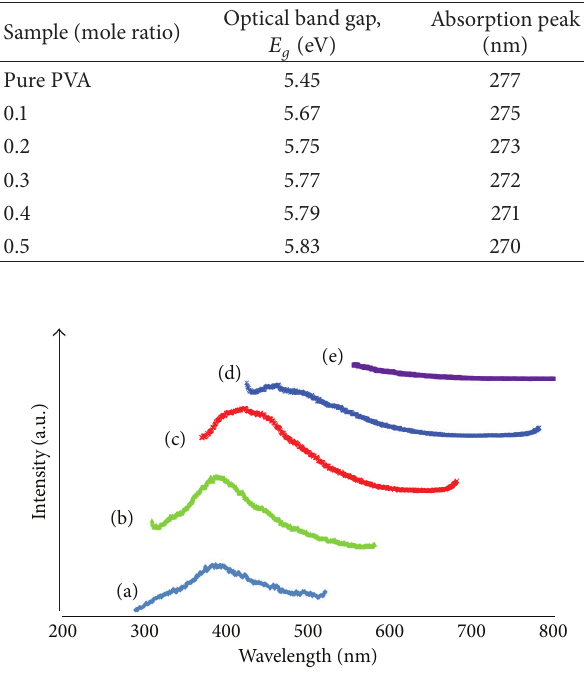
Figure 3: PL spectra of pure PVA and PPVA samples prepared with a mole ratio of 0.3 at five excitation wavelengths: (a) 272; (b) 300; (c) 350; (d) 400; and (e) 500 nm.